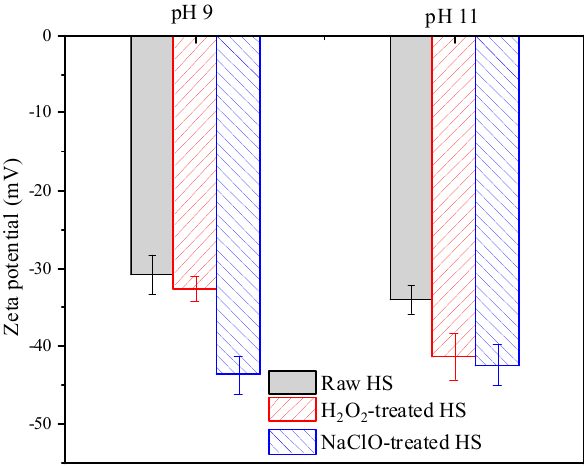
Figure 4. Zeta potential of HS before and after reacting with H 2 O 2 and NaClO. The ratio of oxidant to DOC: 13:1; reaction time: 6 h.